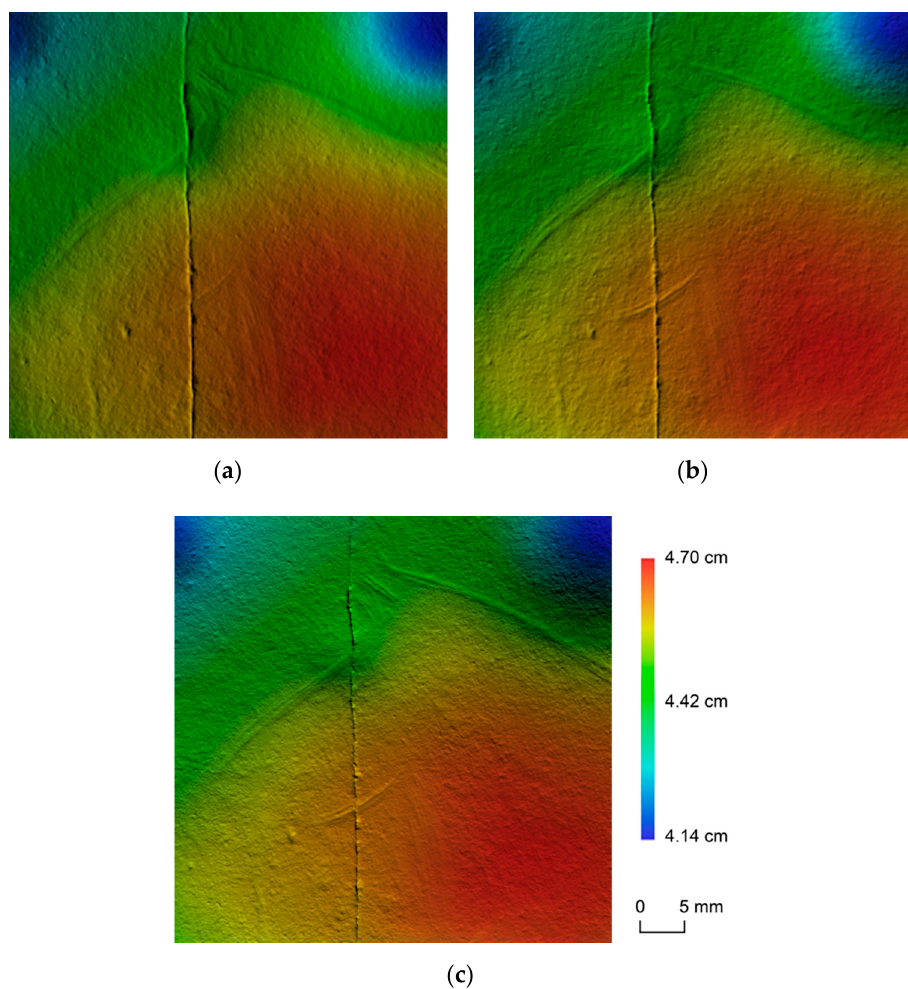
Figure 6. Hillshades detail exported by Agisoft PhotoScan. In each image the position of the light source is different. It moves 60° azimuthally, while the elevation remains constant at 30°: ( a ) azimuth = 75°; ( b ) azimuth = 135°; ( c ) azimuth = 195°.